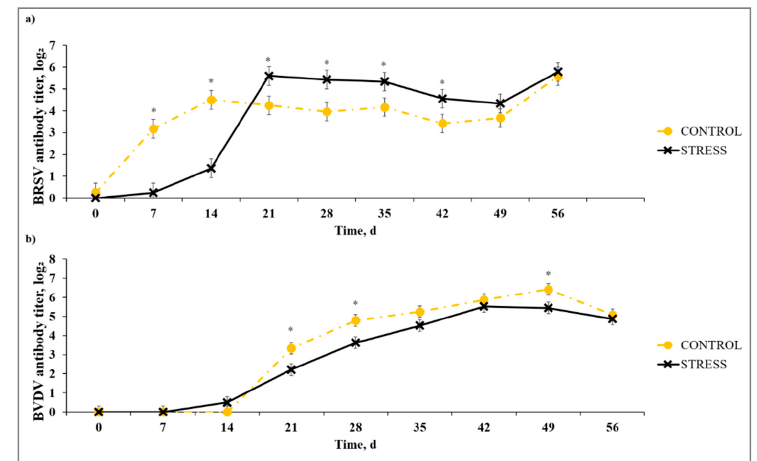
Figure 2. E ff ect of non-stress control (C; weaned on Day − 37; transported to West Texas A&M University (WTAMU) research facility on Day − 21; vaccination on Day 0) and stress model implementation (S: weaned on Day − 3; transported to USDA-ARS Livestock Issues Research Unit on Day − 2; relocated to WTAMU on Day − 1; vaccination on Day 0) on serum antibody concentration against: ( a ) bovine respiratory syncytial virus (BRSV); and ( b ) bovine viral diarrhea virus (BVDV). E ff ect of non-stress control and stress model implementation on serum BRSV-specific antibody titer concentration (stress model × day e ff ect; p < 0.01); serum BVDV-specific antibody titer concentration (stress model ×